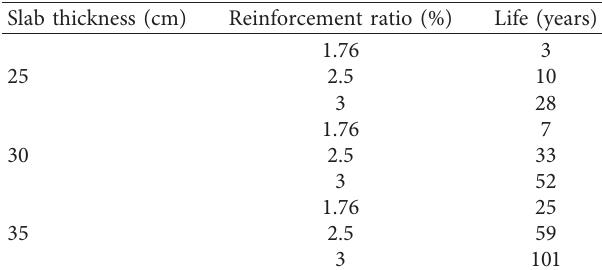
Table 12: Reinforcement life of the deck under different slab thicknesses and reinforcement ratios.